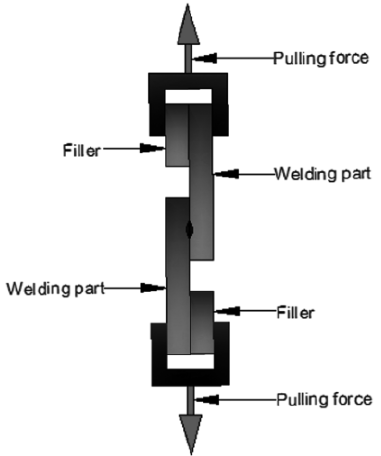
Figure 11. The tensile schematic